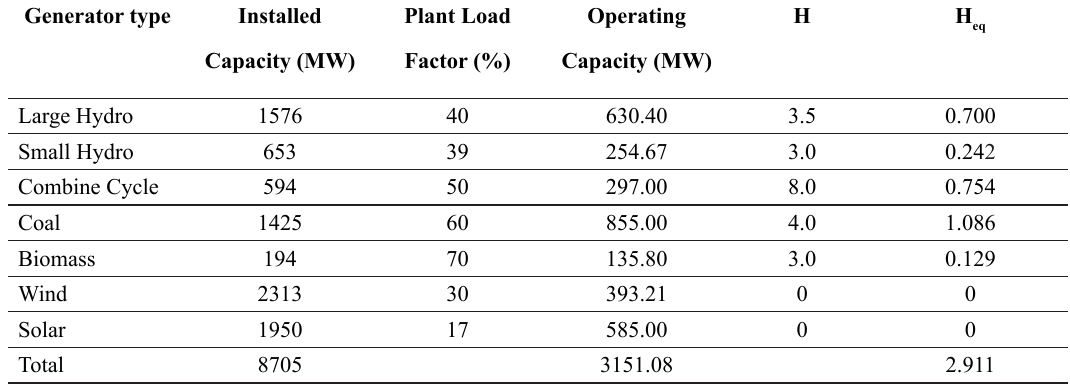
Table 2: Equivalent inertia constants for the year